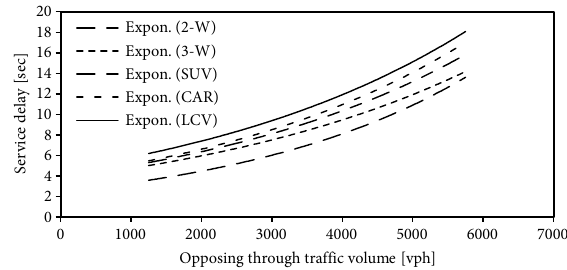
Fig. 10. Effect of opposing through traffic volume on SD